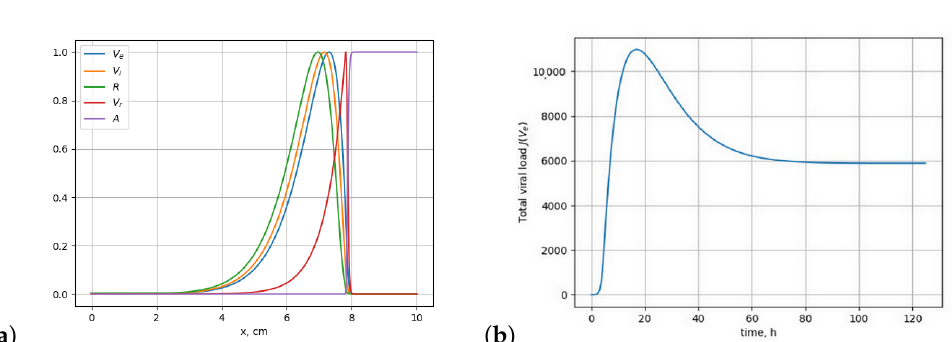
Figure 2. Numerical simulations of system (1)–(5). ( a ) Concentration profiles as functions of space; ( b ) viral load as a function of time. The values of parameters are as follows: D 1 = 0.001 cm 2 h − 1 , k 1 = 0.5 h − 1 , q 1 = 0.09 h − 1 , σ 1 = 0.01 h − 1 , k 3 = 1000 mL (h × unit) − 1 , q 2 = 0.1 h − 1 , σ 2 = 0.36 h − 1 , k 4 = 0.4 mL (h × copy) − 1 ; Initial conditions: V e ( 0 ) = 1 copy/mL, A = 4 unit/mL, V i = V r = R = 0. Normalization (for the left plots): max ( V e ) = 3619.4; max ( V i ) = 635.8; max ( R ) = 845.7; max ( V r ) = 8863.8; max ( A ) =